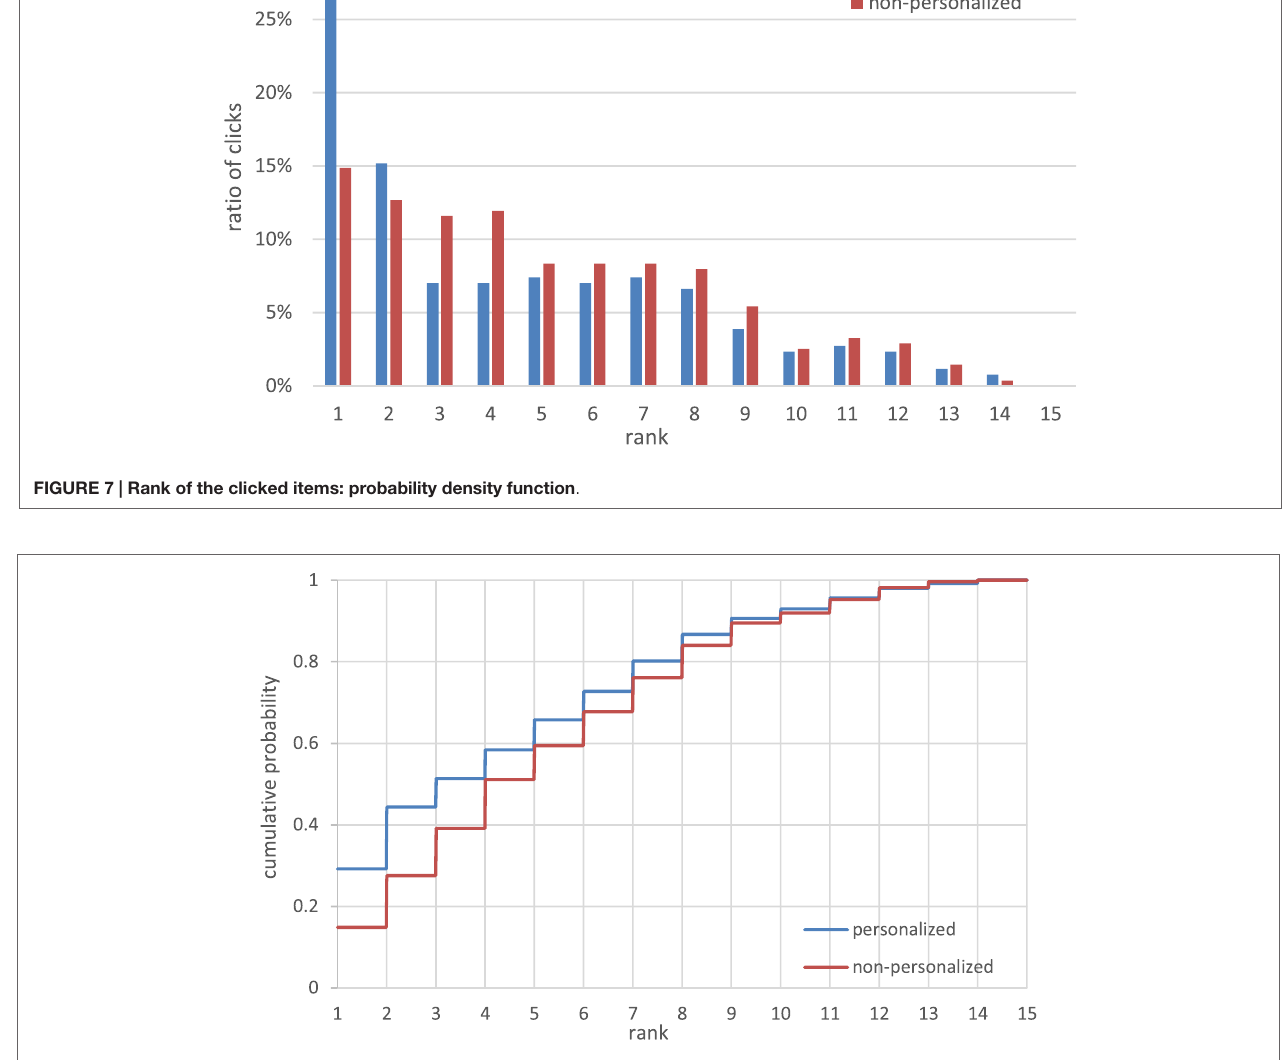
FigUre 8 | rank of the clicked items: cumulative distribution .